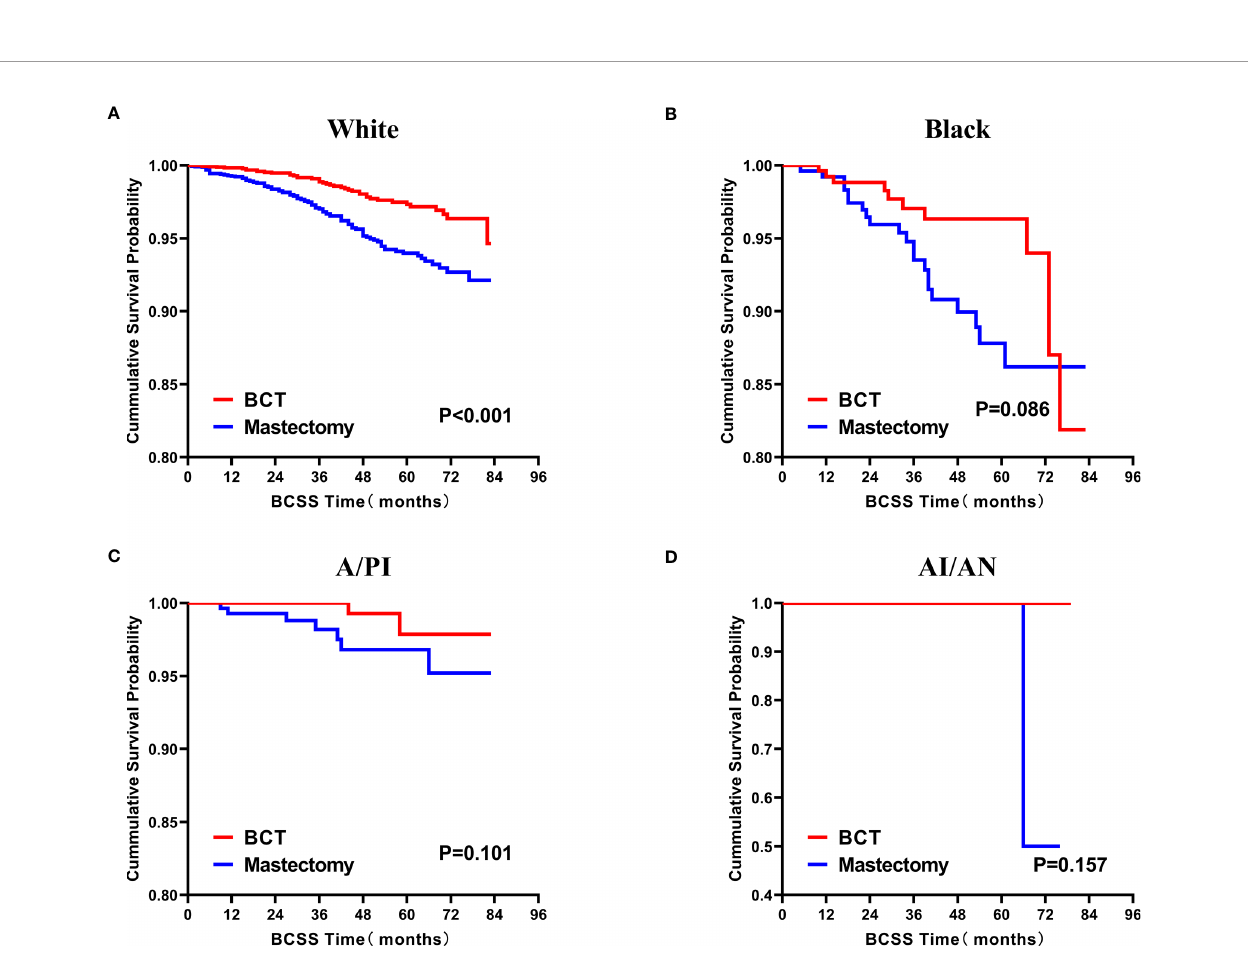
FIGURE 5 | Kaplan – Meier curves for BCSS by treatment type for all patients, strati fi ed by race: (A) White. (B) Black. (C) A/PI. (D) AI/AN. BCSS, breast cancer speci fi c survival; BCT, breast-conserving therapy; A/PI, Asian/Paci fi c Islander; AI/AN, American Indian/Alaskan